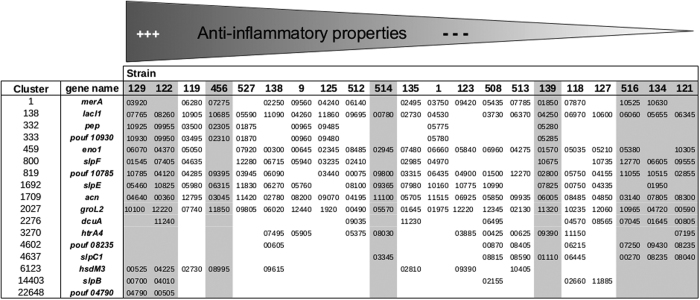
Identification of the Propionibacterium freudenreichii strains containing the genes coding for the candidate proteins identified by a multi-omics approach.The columns highlighted in grey correspond to the strains selected for the transcriptomic analysis. The numbers indicated in the Table refer to the locus tag of the genes; for example merA in strain CIRM 129 refers to the PFCIRM129_03920 gene.